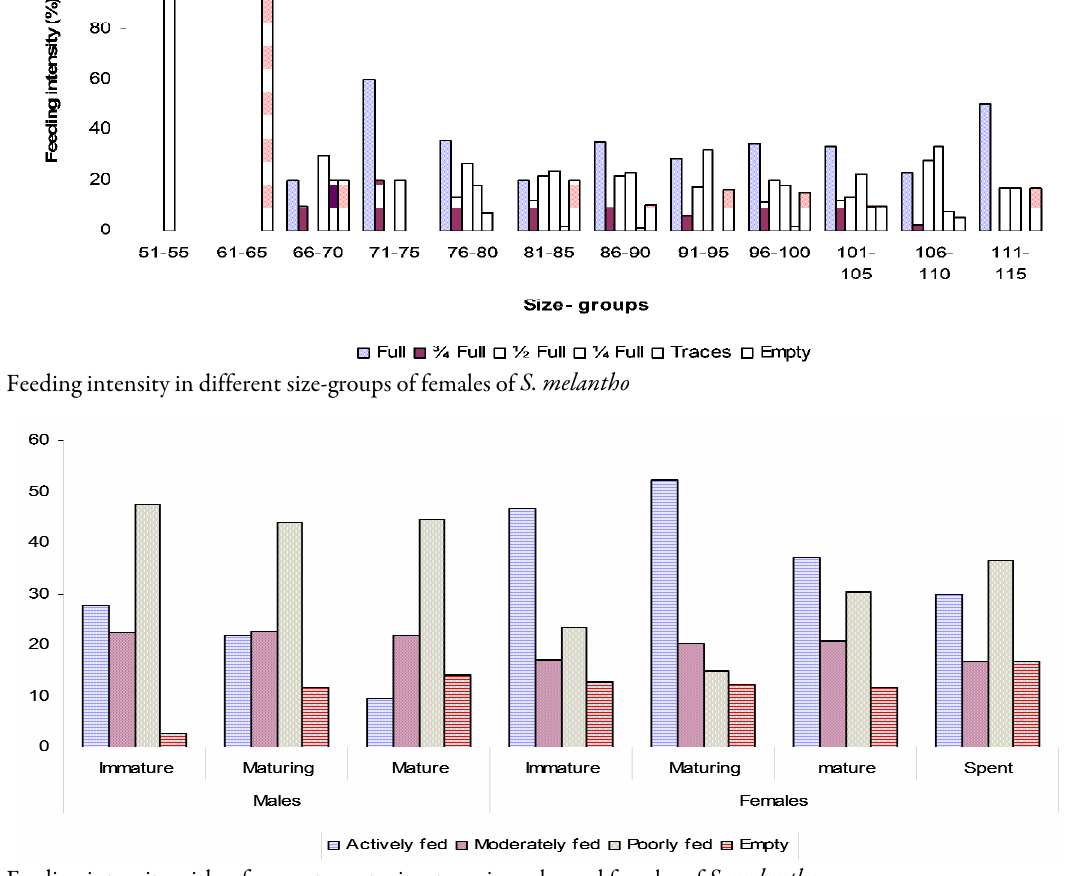
Fig. 12. Feeding intensity with reference to maturity stages in males and females of S. melantho